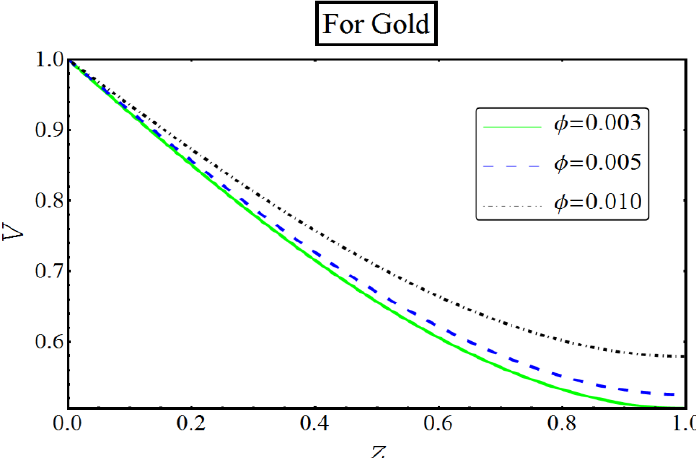
Figure 18. Effects of concentration particles on azimuthal velocity for gold.